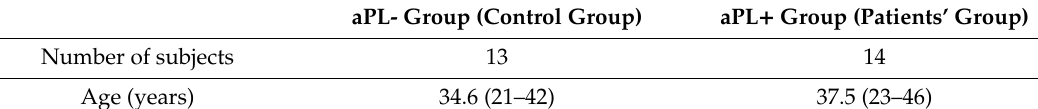
Table 1. A detailed demographic and clinical profile of aPL- and aPL +